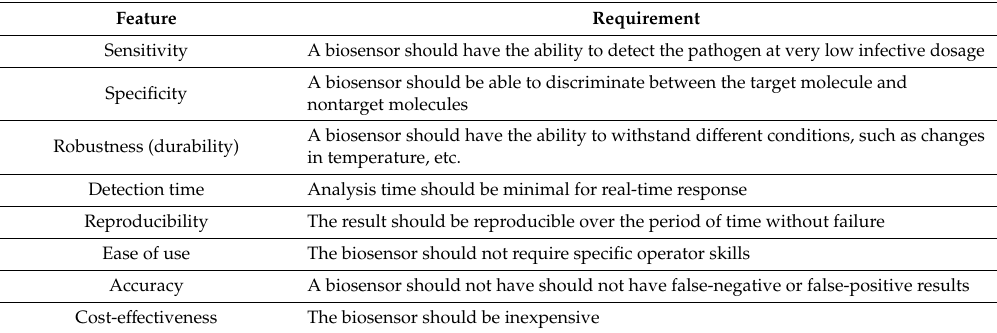
Table 1. Summary of the requirements for a bacterial